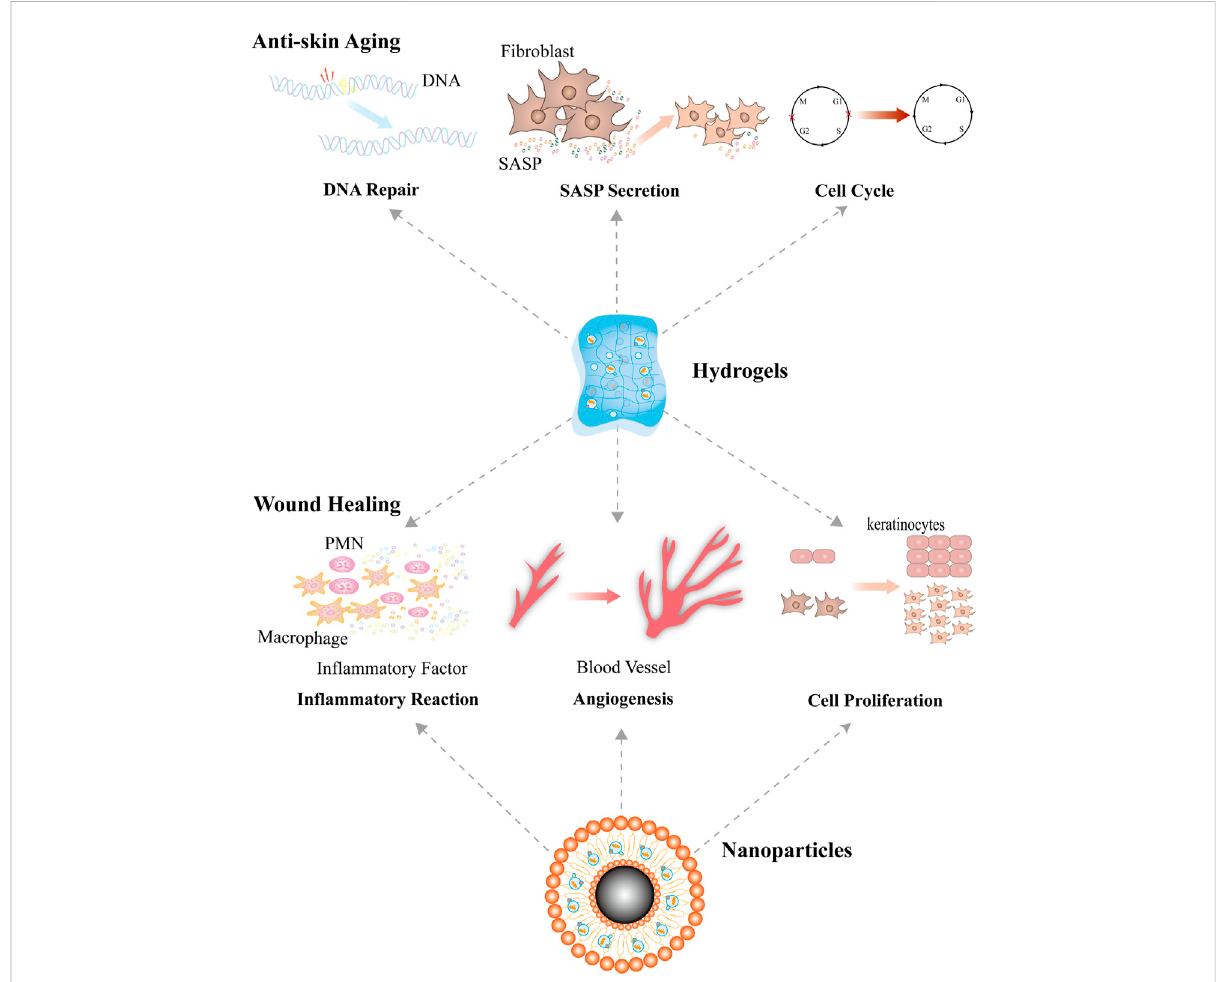
FIGURE 5 EngineeredEVsforskinrepairs.CombiningEVswithhydrogelsornanoparticlessigni fi cantlyoptimizestheirtherapeuticeffects.Comparedwith natural EVs, engineered EVs have stronger effects in promoting cell proliferation, accelerating DNA repair, enhancing angiogenesis, modulating in fl ammation, and suppressing the secretion of SASP factors, and therefore they have better performance in the therapy of chronic